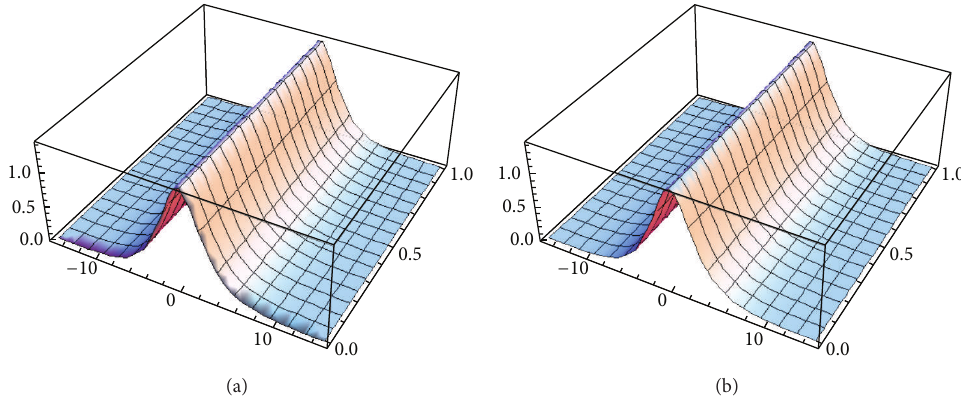
Figure 15: Graph of the solution (57) corresponding to the values 𝛼 = 0.05 , 𝛼 = 0.85 , respectively, when 𝑘 = 1 , 𝑝 = 2 , 𝛾 = 3 , −15 < 𝑥 < 15 , and 0 < 𝑡 < 1 .